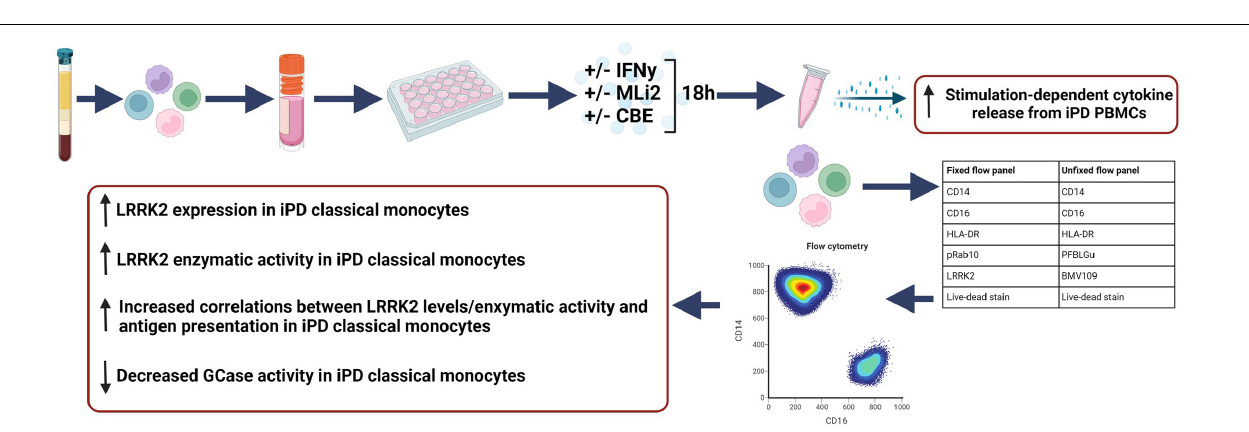
FIGURE 7 | WHOPPA assay and summary findings. The Wallings-Hughes Optimized Protocol for PBMC Assessment (WHOPPA) with each optimized element (sample collection, cryopreservation, isolation, and flow cytometry antibodies) and a summary of results from the first application of this protocol. Created with